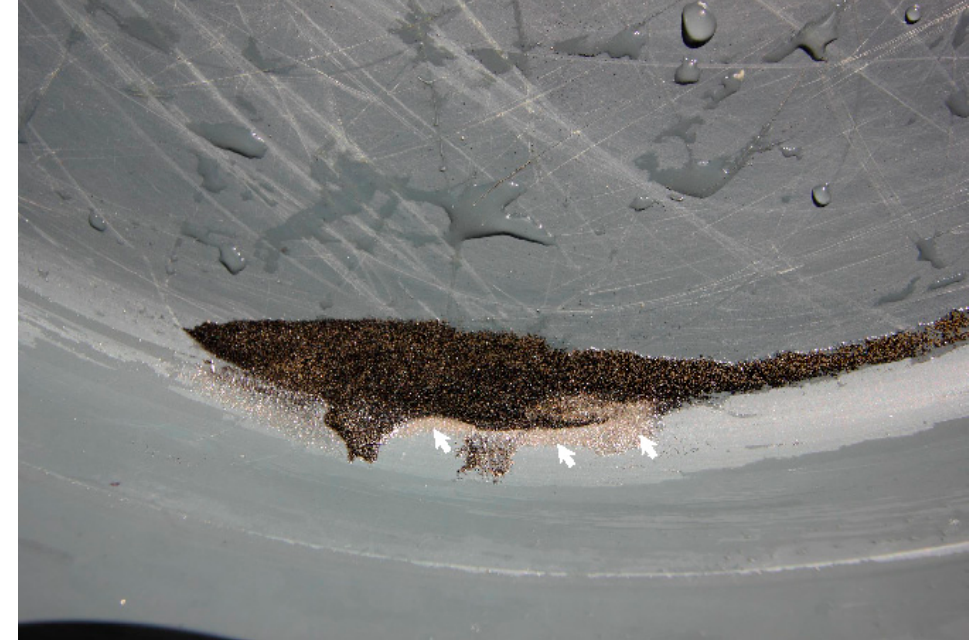
Figure 10. Final product of the washing process. Note the silver streak of the value minerals (arrows). For scale purposes, the photograph is approximately 7 cm in the longest dimension.